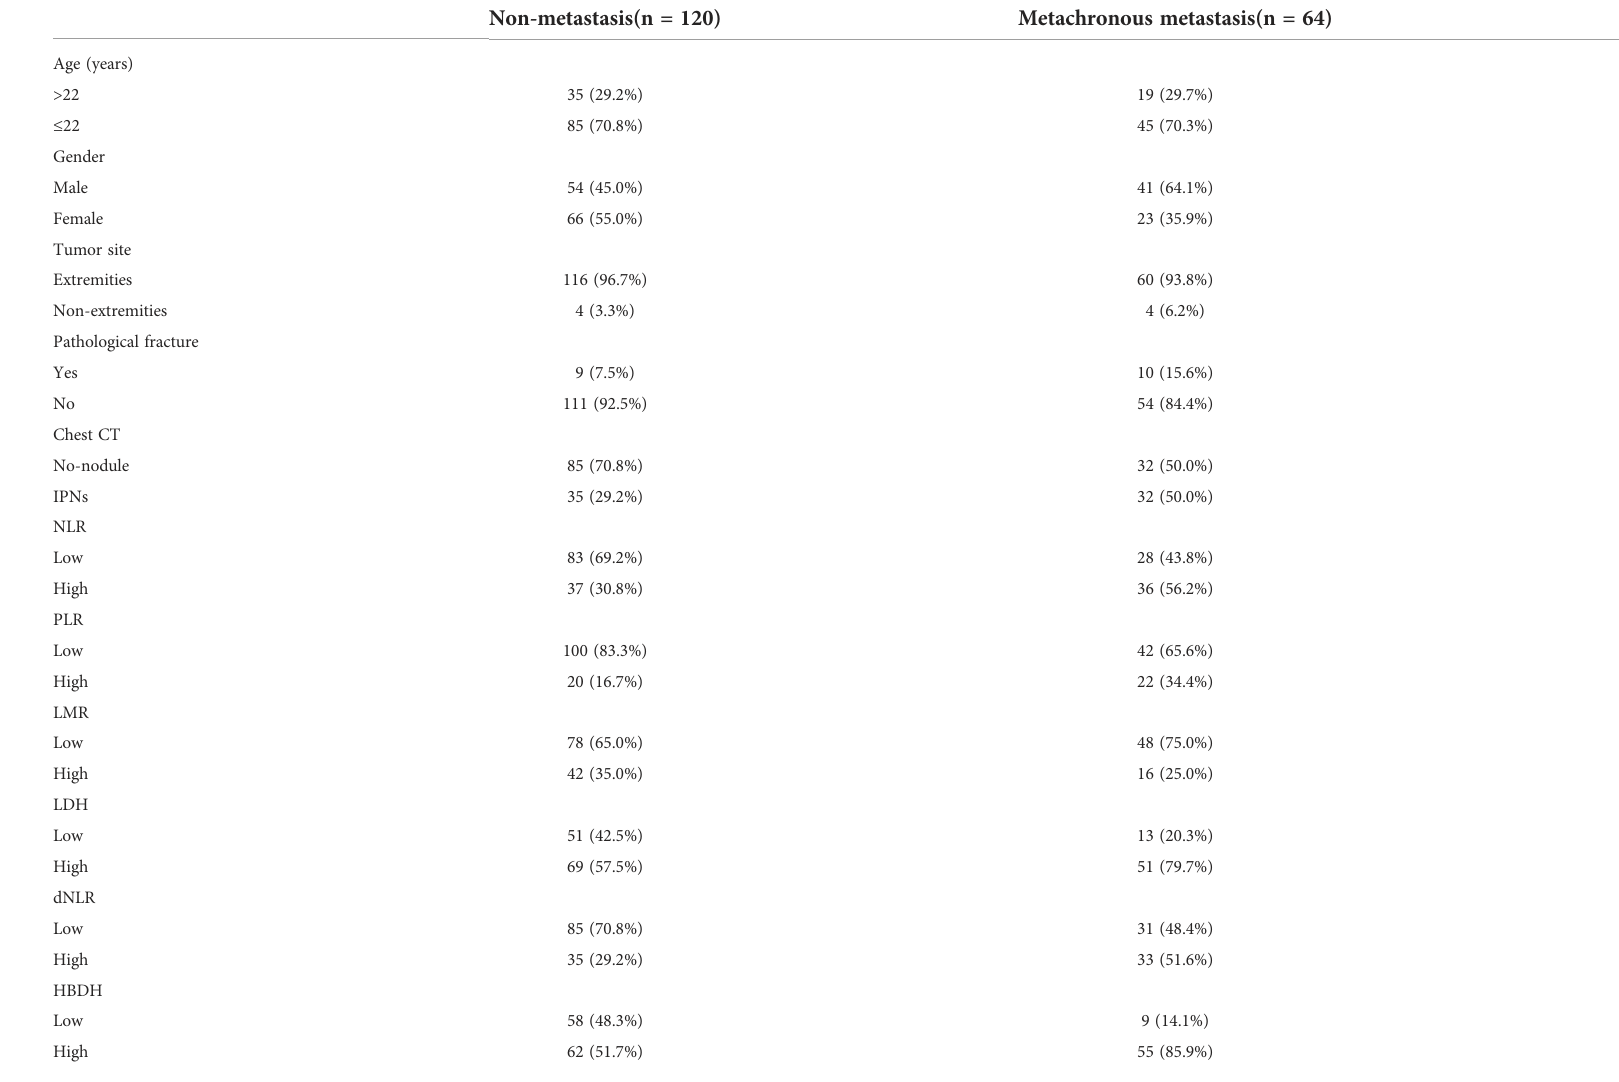
TABLE 1 Characteristics of 184 osteosarcoma